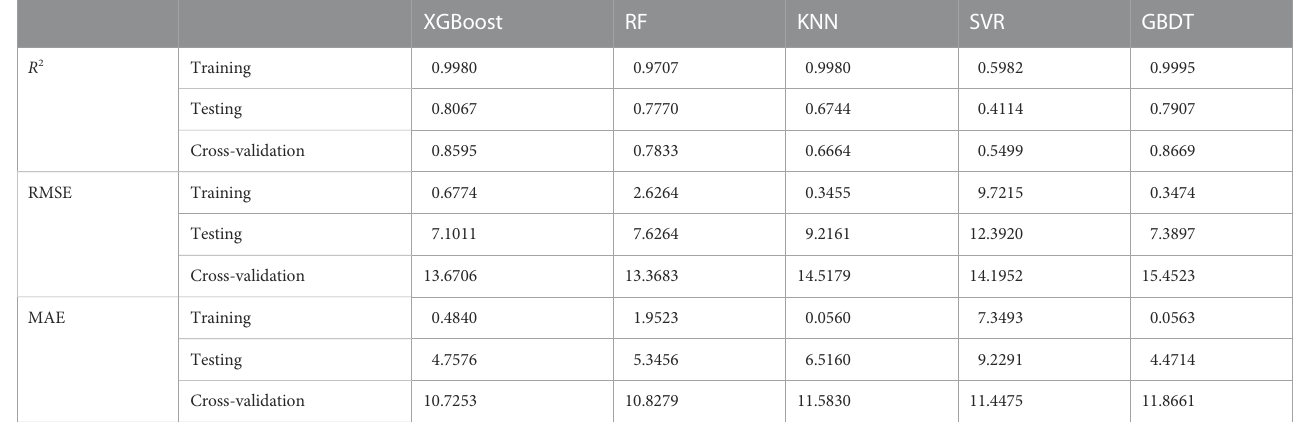
TABLE 4 Performance comparison of prediction models of different RA